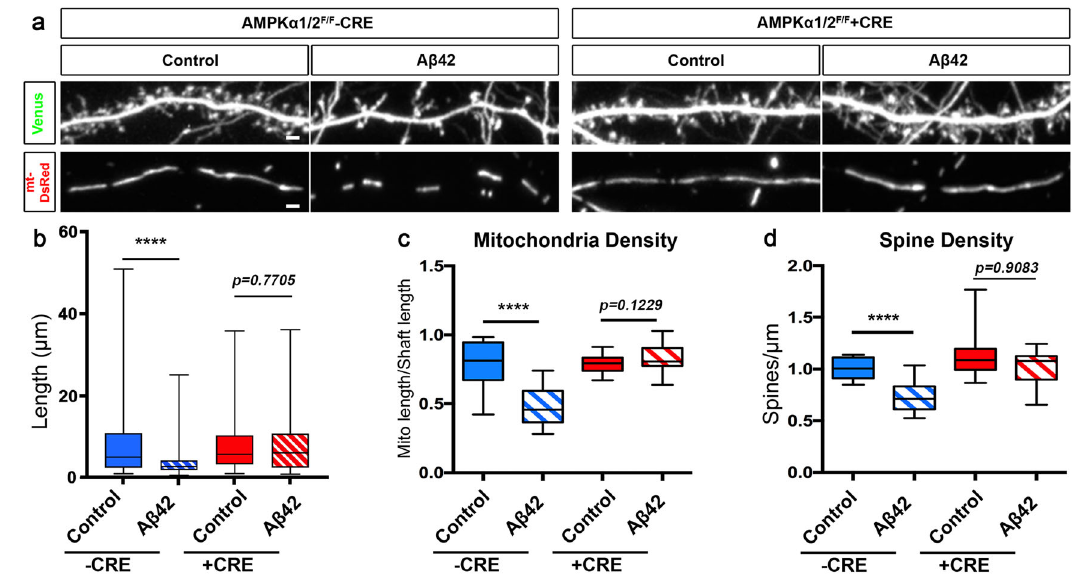
Fig. 4 | Oligomeric A β 42-inducedsynaptotoxicityand dendriticmitochondrial fragmentation is AMPK-dependent. a Secondary dendritic segments of primary cortical PNs at 21 DIV. Embryos from AMPK α 1/ α 2 double conditional knockout (AMPK α 1 F/F / α 2 F/F )wereexuteroelectroporatedatE15.5withpCAG-mVenus,pCAG- mito-DsRed, and either scrambled pCAG-Cre (control) or pCAG-Cre recombinase. Neurons were treated at 20 DIV with either a vehicle control or A β 42o for 24h. b – d Quanti fi cation of b mitochondria length, c mitochondrialdensity, and d spine density inindividualdendriticsegments. All of the analyses were done blind to the experimental conditions and were done by manual counting using FIJI. Data is